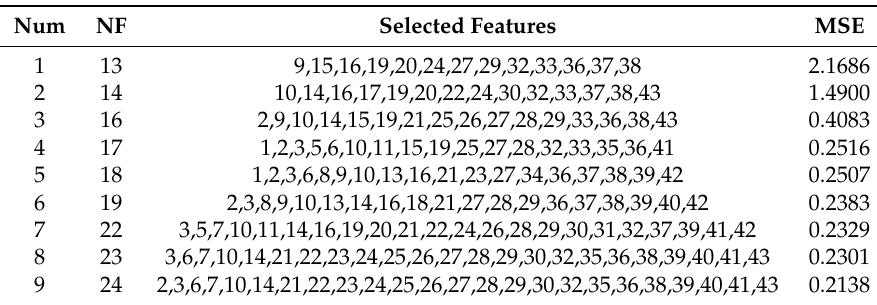
Table 4. Pareto Front Details in UNSW-NB15